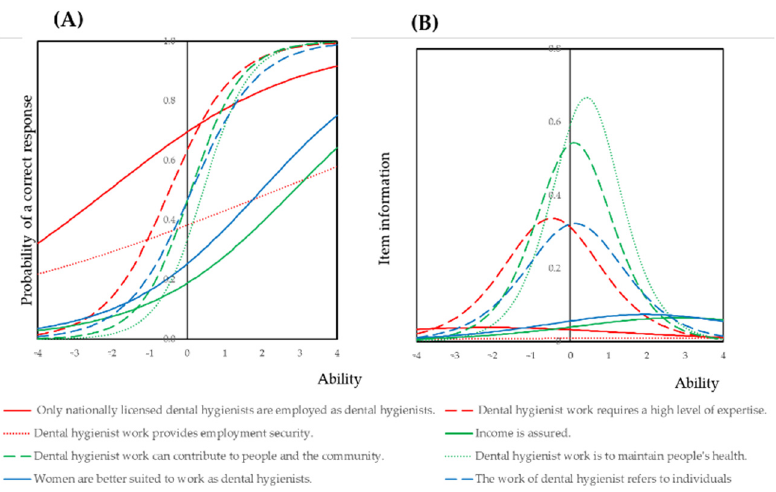
Figure 1. Item response and item information curves of the eight items contributing to the job satisfaction of dental hygienists. ( A ) Item response curve. ( B ) Item information curve.